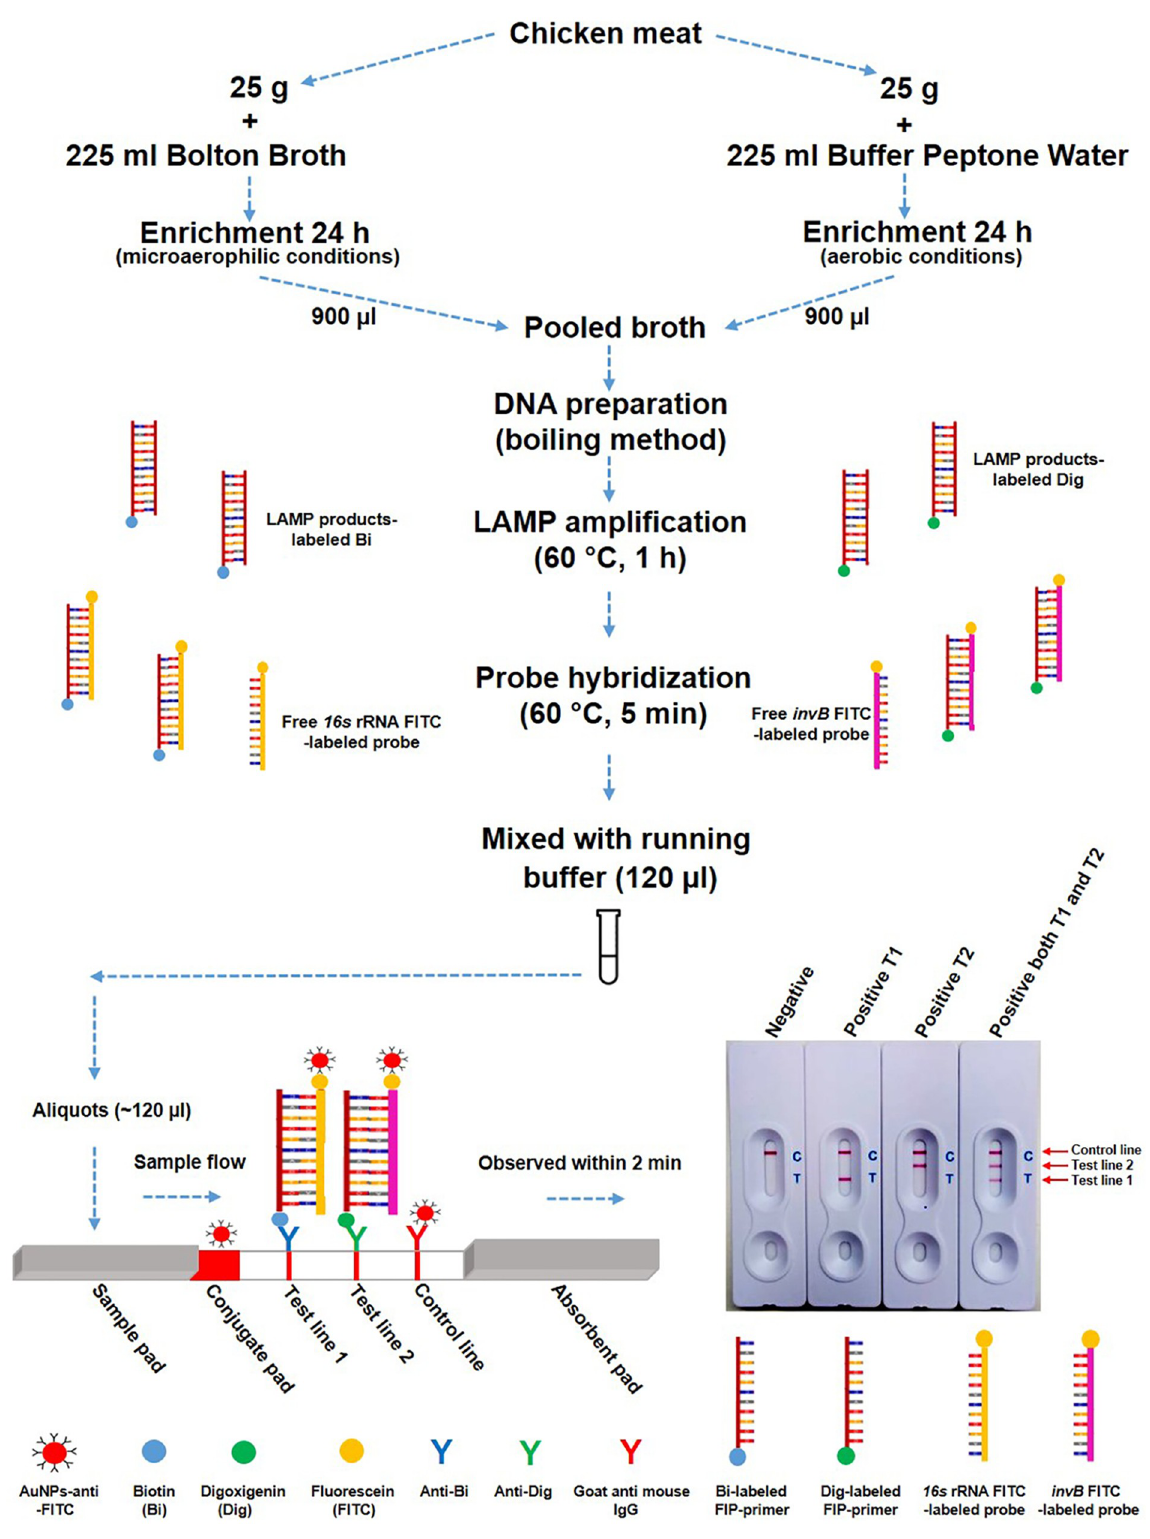
Fig 1. Schematic depiction of d-LAMP-LFB for simultaneous detection of Campylobacter and Salmonella spp.